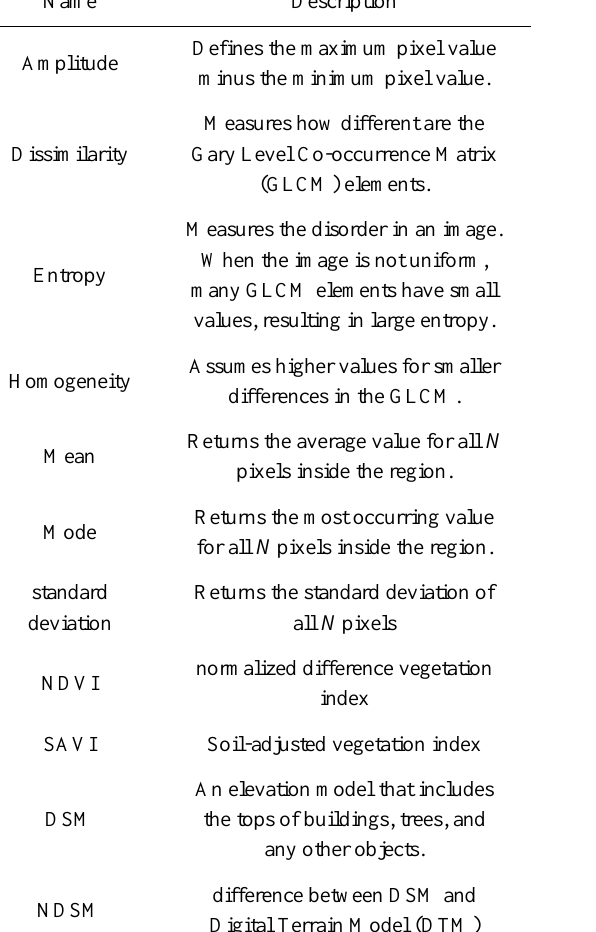
Table 1. Spectral features extracted from the segments